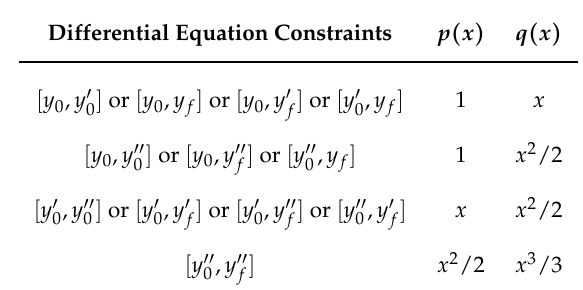
Table 1. Simplest selection of p ( x ) and q ( x ) for various initial value problem and boundary value problem